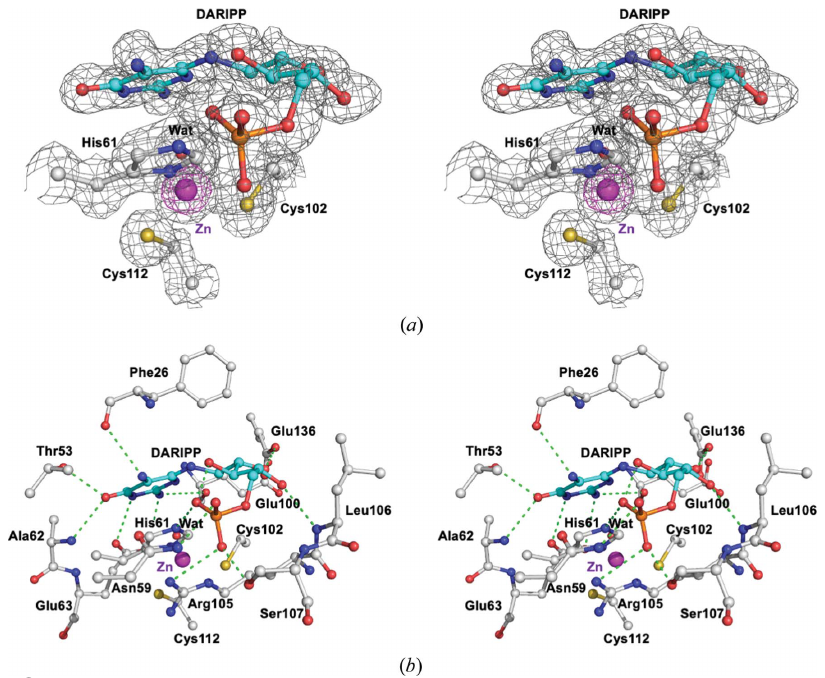
Figure 3 The DARIPP-binding site in AoRib2. ( a ) The 2 F o (cid:3) F c composite OMIT map of the active site contoured at the 1.0 (cid:5) and 8.0 (cid:5) levels and drawn as gray and magenta mesh presentations, respectively. ( b ) Interaction networks between DARIPP and AoRib2. DARIPP is displayed in cyan. Hydrogen bonds are shown as green dashed lines.